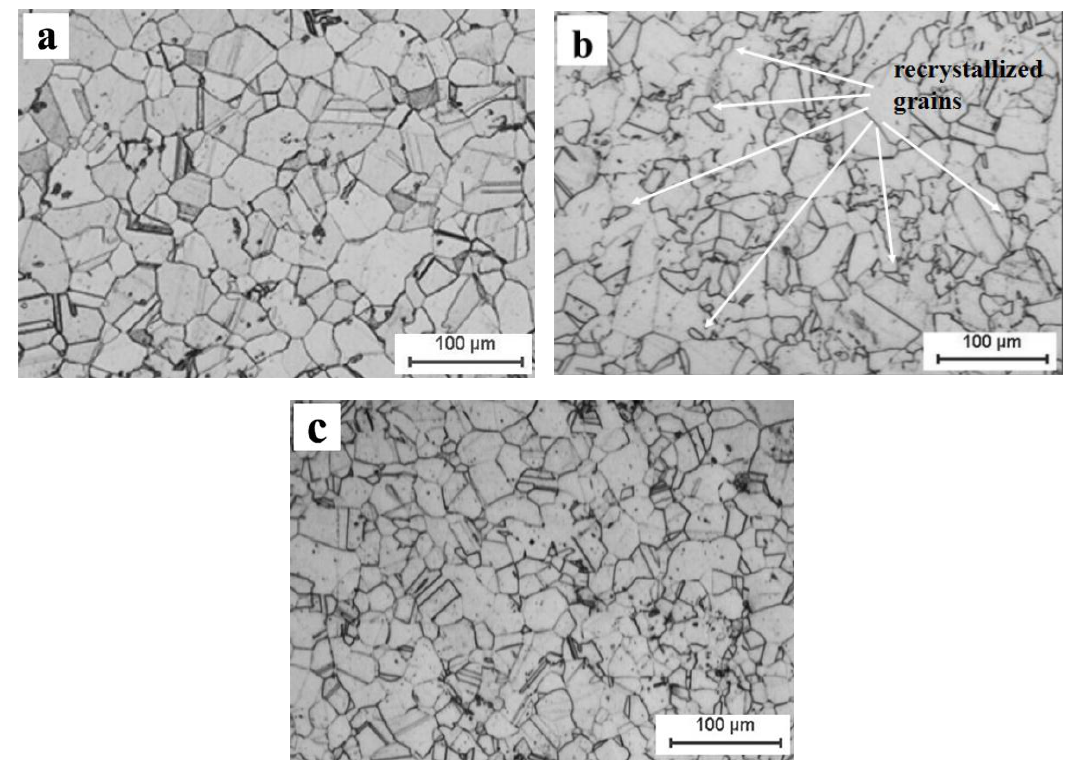
Figure 2. The microstructures of the superalloy under different deformation conditions: ( a ) initial; ( b ) 1323 K, 0.001 s −1 , deformation amount = 40%; ( c ) 1323 K, 0.001 s −1 , deformation amount = 70%.